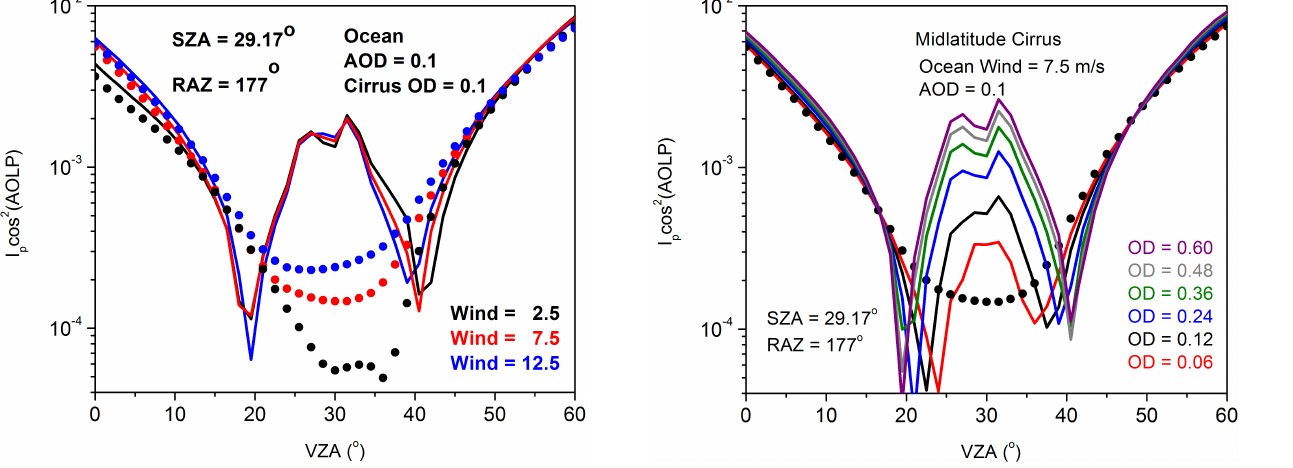
Figure 7. Modeled p-polarized reflectance at a wavelength of 670nm as a function of viewing zenith angle (VZA), and at a rela- tive azimuth angle (RAZ) of 177 ◦ for super-thin cirrus clouds over oceans with different optical depth (OD) (solid curves). Also shown in the figure is the result for clear oceans (black dots). In the mod- eling, the solar zenith angle (SZA) is 29.17 ◦ , the wind speed is 7.5ms − 1 , and the aerosol optical depth (AOD) is 0.1. The size dis- tribution of the ice particles in the cirrus clouds is from Heymsfield and Platt (1984) for the cloud temperature of − 20 to − 25 ◦ C. The mid-latitude cirrus clouds are composed of a mixture of complex particle shapes as described in Baum et al. (2000). These results suggest that the OD retrieval method may only work well for thin clouds which have OD< ∼